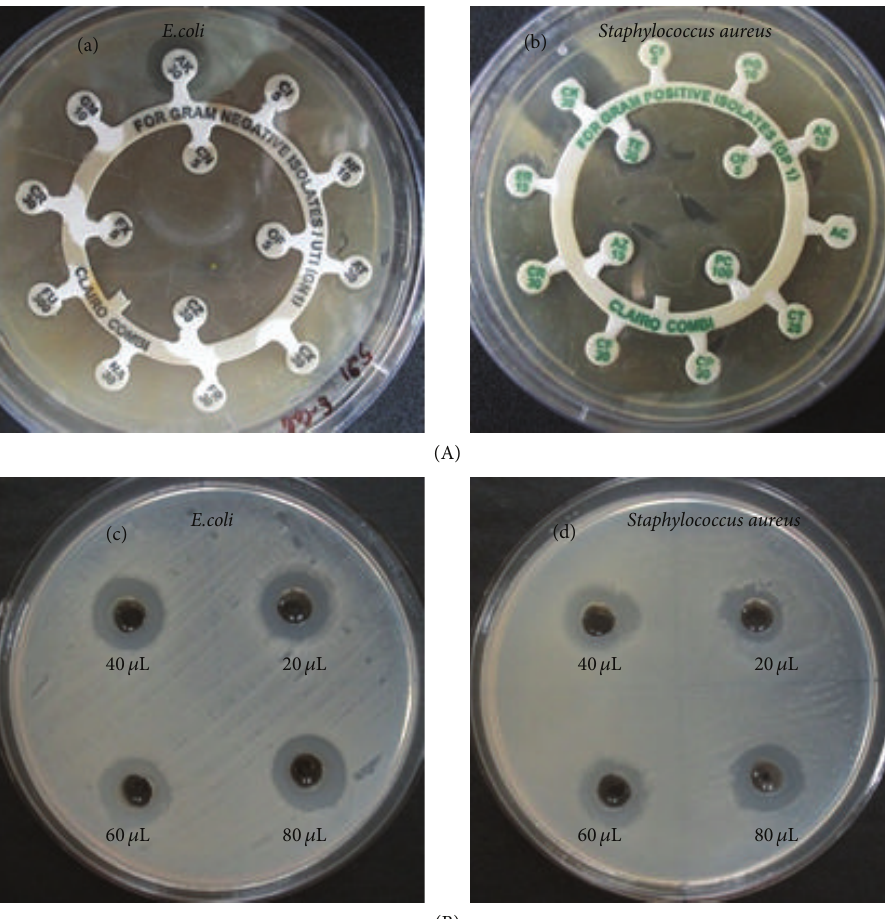
Figure 10: (A) Antibiotic susceptibility test of (a) E. coli and (b) S. aureus. (B) Antibacterial activity of AgNps synthesized by endophytic fungus Penicillium sp. against above confirmed MDR strains of (c) E. coli and (d) S.